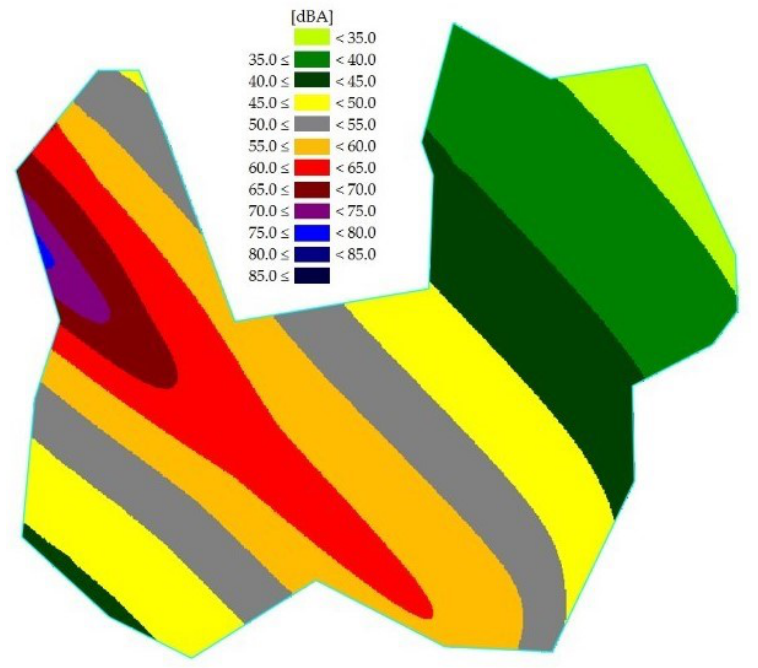
Figure 6. Aircraft noise map of the research